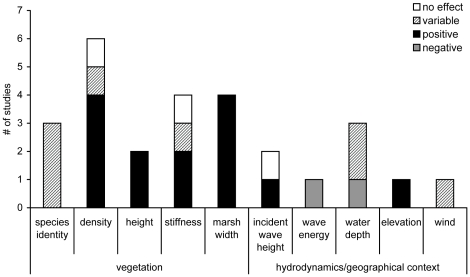
The factors most commonly quoted as being of importance to the wave attenuation capacity of salt marsh vegetation.The height of each bar indicates the number of author statements or conclusions regarding each factor and the bar fill indicates the effect of an increase in each factor on wave attenuation. For example, four studies showed that increasing marsh width increases wave attenuation indicating a positive relationship (black fill) between marsh width and wave attenuation.